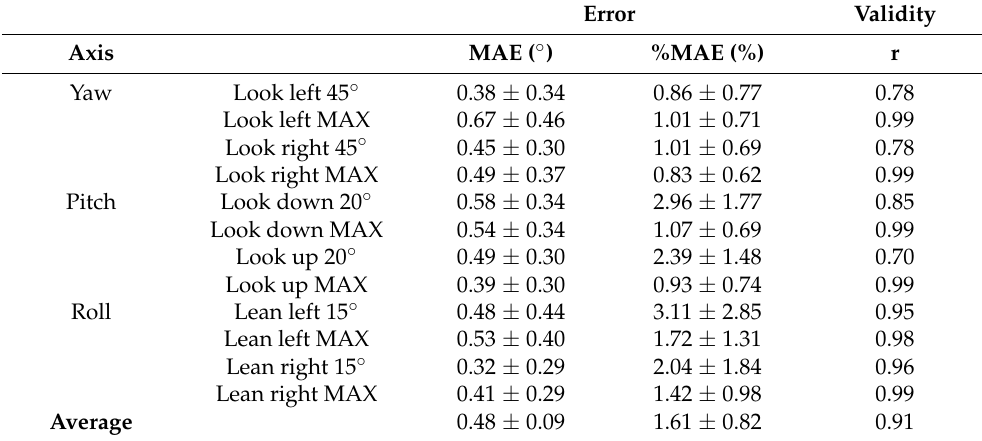
Table 2. Error and validity results in rotational movements comparing the HMD system and the